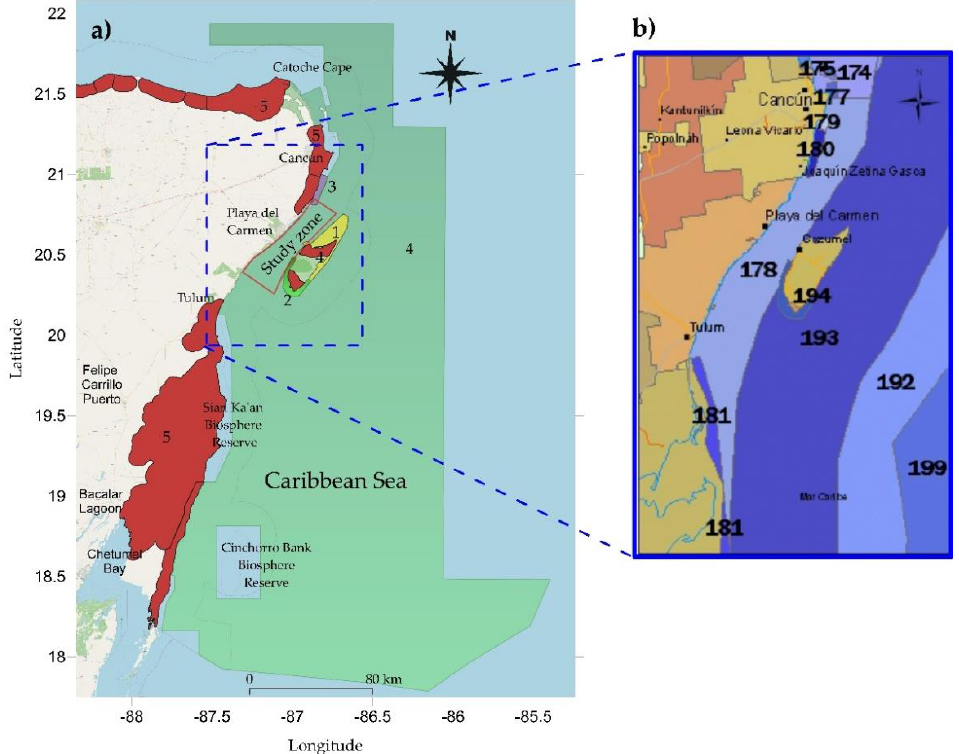
Figure 10. ( a ) Protected Natural Areas and priority sites. ( b ) Environmental Management Unit (UGA) 178 in which the study area is located [71].